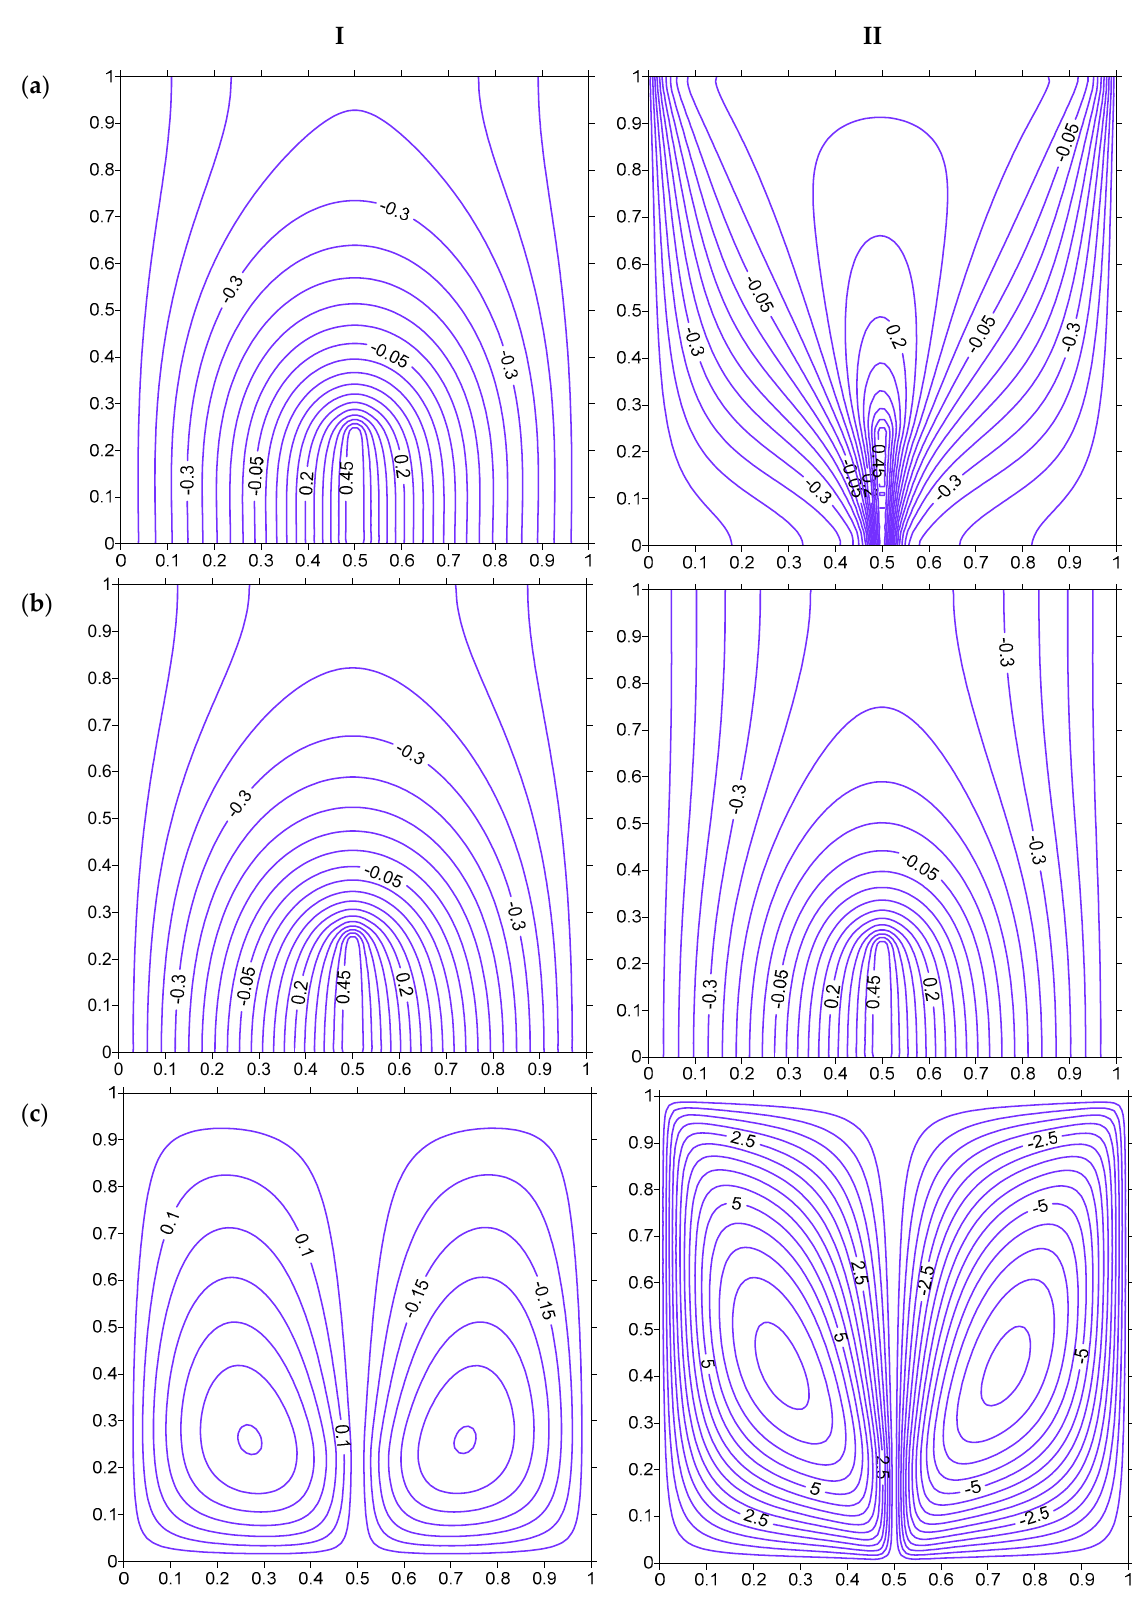
Figure 12. Isotherms (( a ) Fluid, ( b ) Solid), and streamlines ( c ), at H = 5, HH = 25%, Kr = 1, Rd = 0 for strip at x = 0.5. ( I ) Ra = 100. ( II ) Ra =